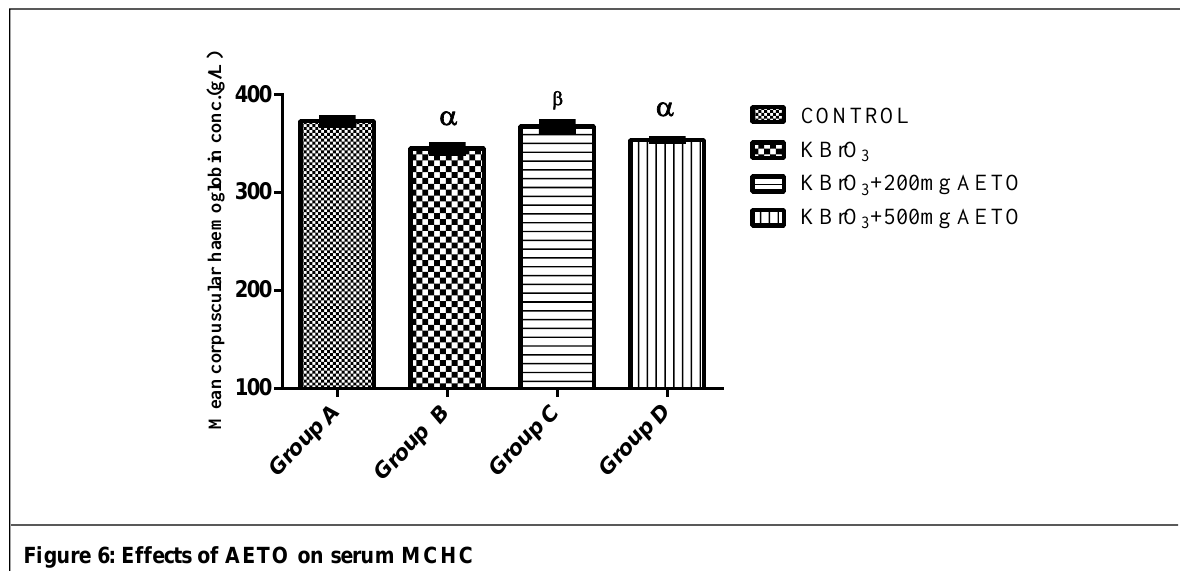
Figure 6: Effects of AETO on serum MCHC Note: Value of p < 0.05 was considered significant. The values with superscript  = significantly different from group A,  = significantly different from group B. MCHC – Mean Corpuscular Hemoglobin